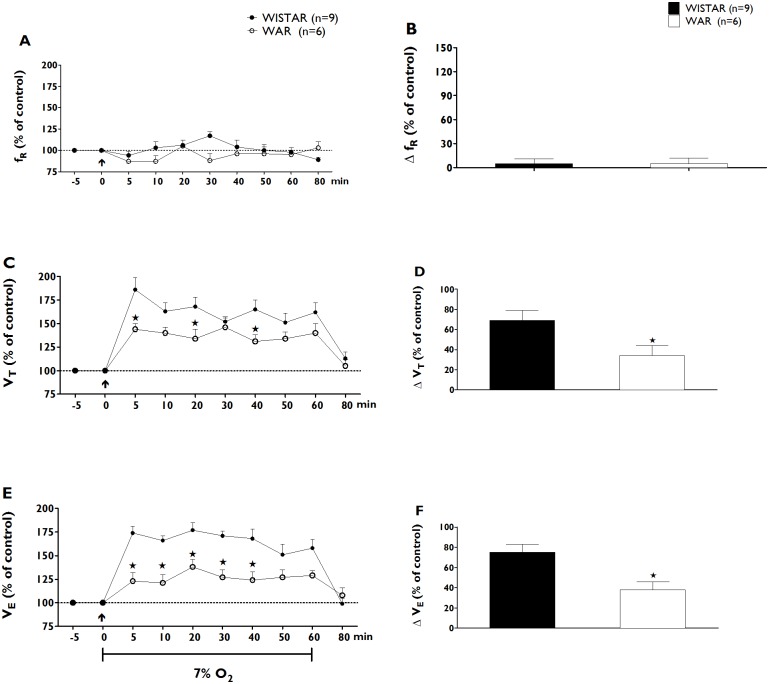
Changes in Respiratory variables after Hypoxia.Time-course of respiratory frequency (fR, % of control, A), tidal volume (VT, % of control, panel C) and minute ventilation (VE, % of control, E) changes during 60 min of hypoxia (7% O2) in Wistar (blue dots) and WAR groups (red dots). Peak changes in baseline respiratory frequency (ΔfR, % of control, B), tidal volume (ΔVT, % of control, panel D) and minute ventilation (ΔVE, % of control, F) 20 min after the beginning of hypoxia (7% O2) in Wistar (blue bars, n = 9) and WAR groups (red bars, n = 6). The arrow indicates the moment of the establishment of hypoxia. Data are expressed as mean ± SEM. p<0.05, Two-way ANOVA followed by Bonferroni’s post hoc test. (*) Significantly different from Wistar control group.